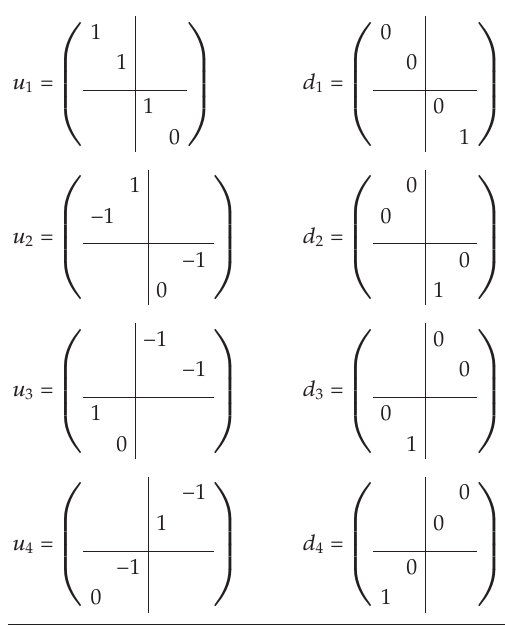
Table 2: Linkage matrices for the left 3-4-1 Adinkra shown in Figure 2. The linkage matrices for the right Adinkra in that figure are obtained from these by changing the sign of u 3 and d 3